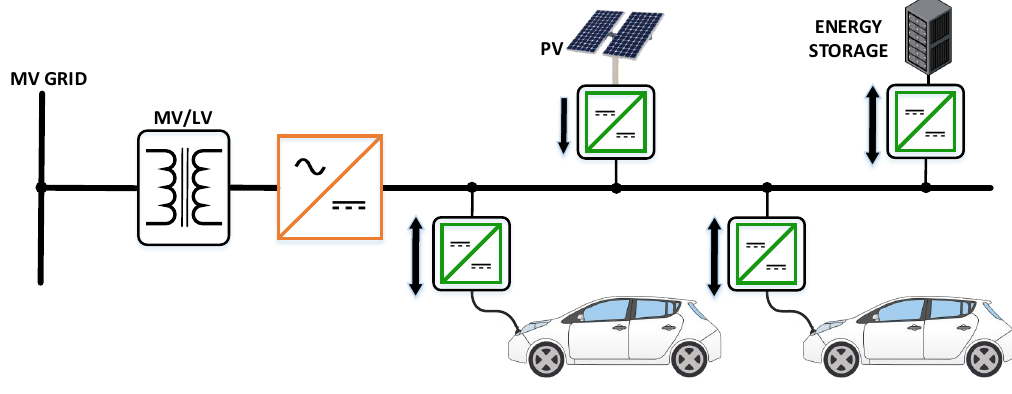
Figure 7. DC coupled charging